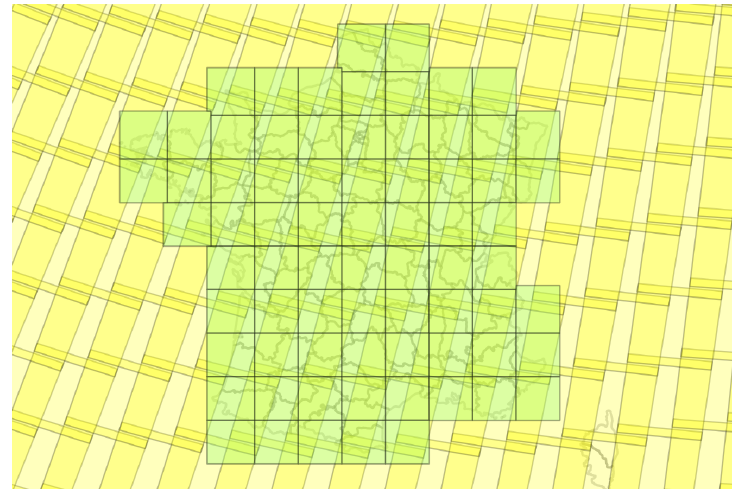
Figure 10. Image tiling for storage and processing. The green squares are the 78 tiles of